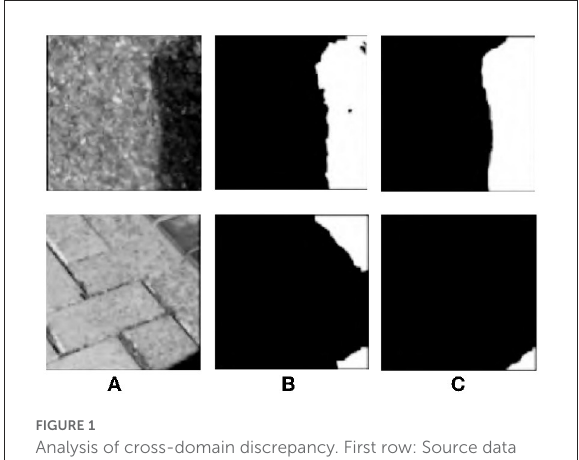
FIGURE1 Analysis of cross-domain discrepancy. First row: Source data set. Second row: Target data set. First column: shadow image (A) . Second column: CGAN method (B) . Third column: proposed method (C)